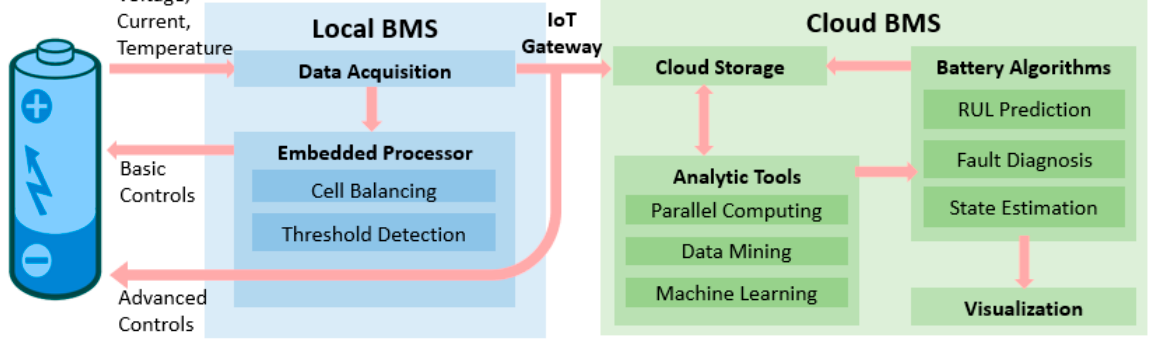
Figure 2. Potential design and functions of the cloud-based smart BMS.